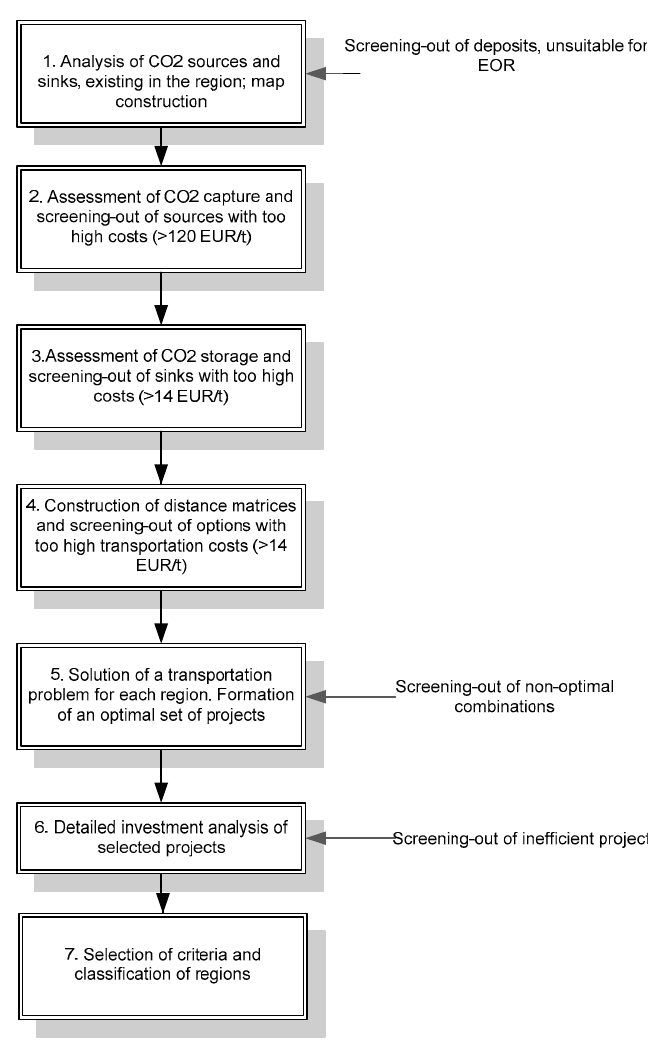
Figure 3. Algorithm of project selection and region classification. Table 1. Main field-geological parameters of CO 2 -EOR applications [27,50].